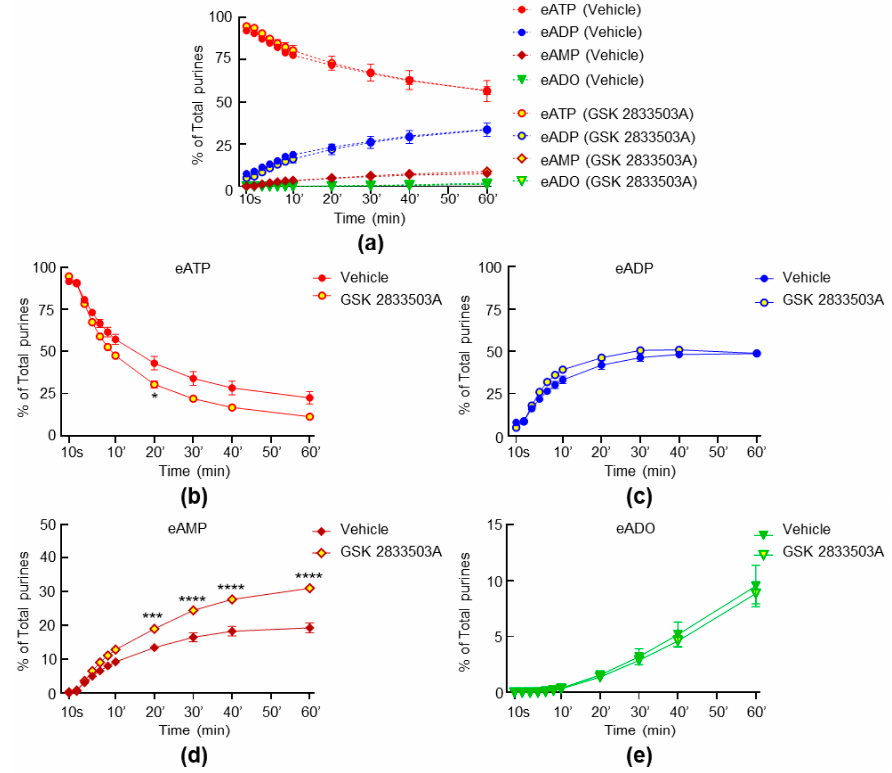
Figure 6. Effects of GSK 2833503A on the hydrolysis of eATP by s-ENTDs released in cELS of detrusor-free bladder preparations. Changes in eATP, eADP, eAMP and eADO in the presence of vehicle (DMSO 0.2%, n = 6) and GSK 2833503A, 1 µM ( n = 3) in nondistended ( a ) and distended ( b,c,d,e ) bladder preparations; n , number of bladder preparations. eATP, eADP, eAMP and eADO are presented as percentages of total purines (eATP + eADP + eAMP + eADO) present in reaction solutions. Asterisks denote significant difference from vehicle controls. * p < 0.05, *** p < 0.001, **** p < 0.0001. Two-way ANOVA with Sidak’s multiple comparisons tests.